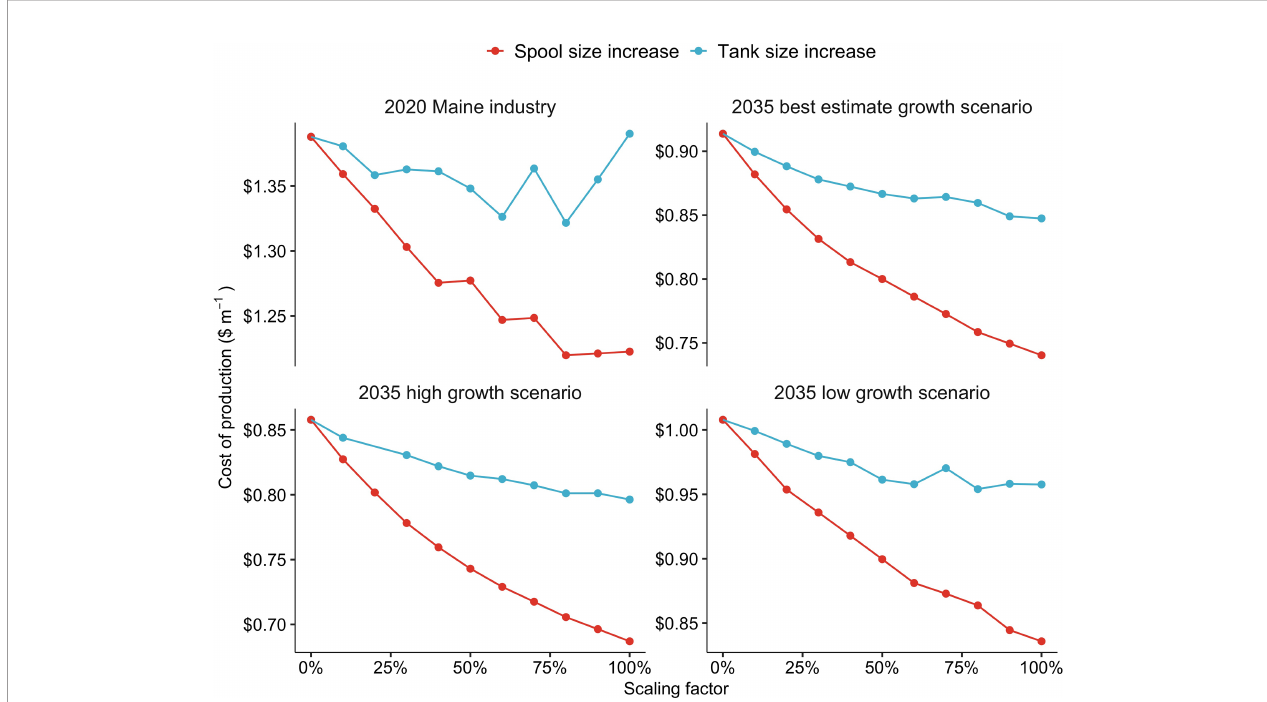
FIGURE 6 | The effects of increases in either spool (red) or tank ( blue ) size on production costs ($ m -1 ) within a kelp nursery producing 101,880 m (2020 Maine industry), 623,000 m (2035 best estimate growth scenario), 1,214,200 m (2035 high growth scenario), or 313,300 m (2035 low growth scenario) of seeded twine, annually. The scaling factor represents a % increase in both the diameter and height of the PVC spools, as well as a % increase in both the length and width of the